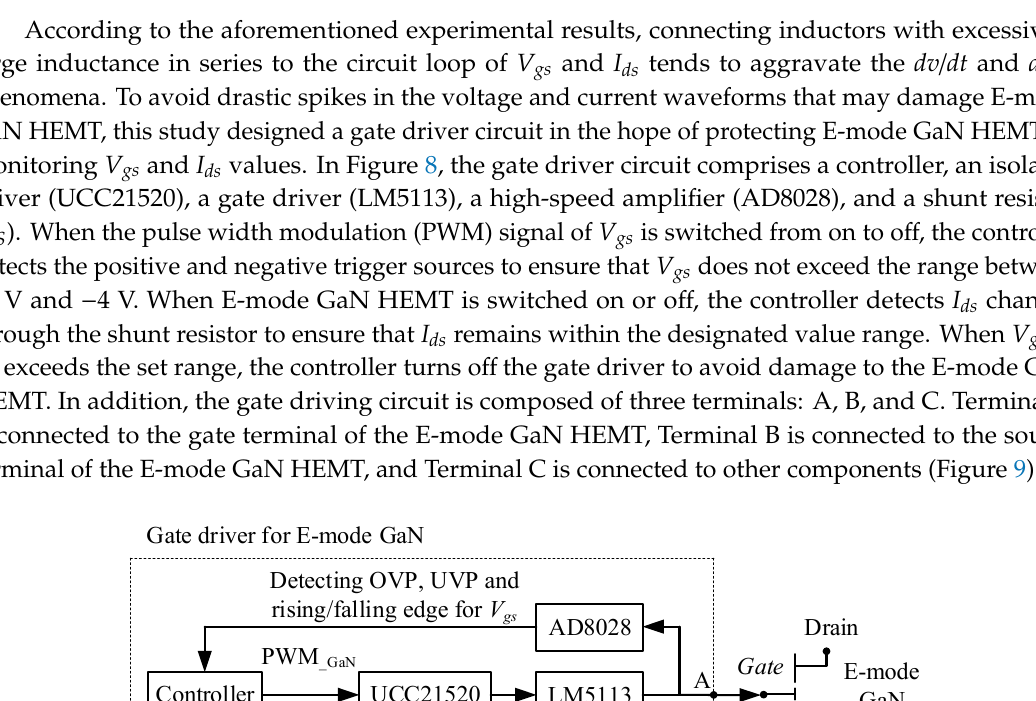
Figure 7. Changes in V ds and V gs when different f s values are applied.